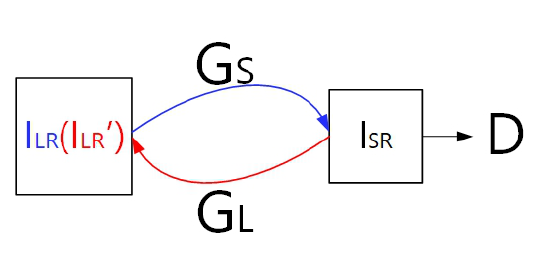
Figure 5. Pipeline of the generator of our CycleGAN network.